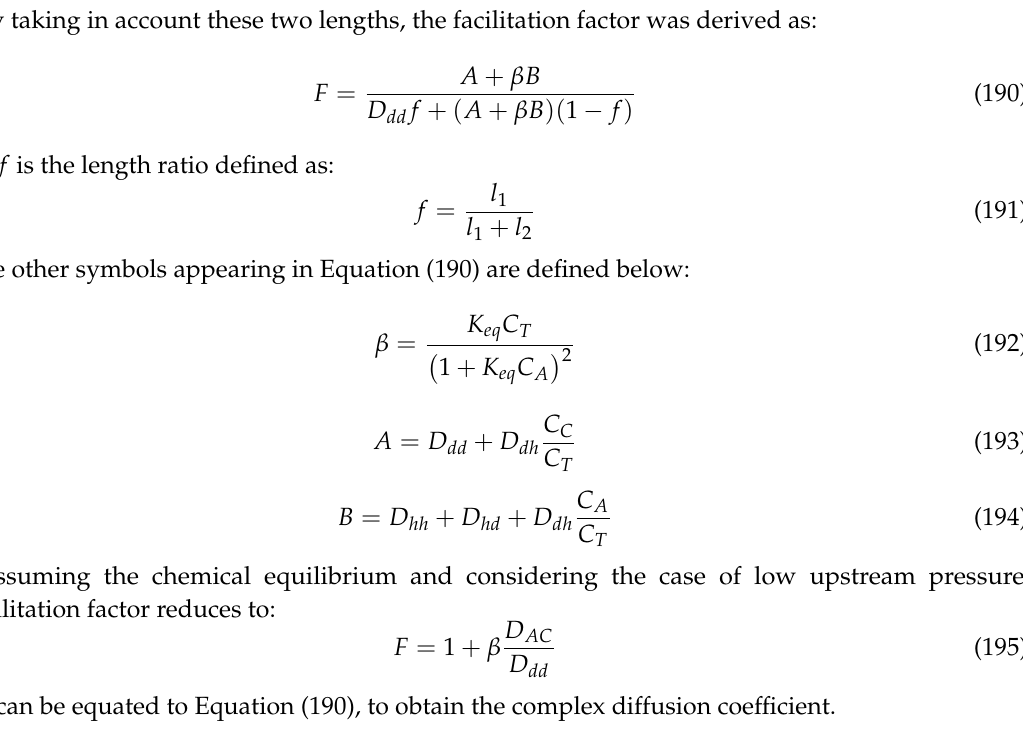
Figure 14. Membrane environment in the present work of Noble. Between sites, in the length space l 2 , pure diffusion mechanism exists. Closely to the sites position, l 1 , Equation (184) holds.